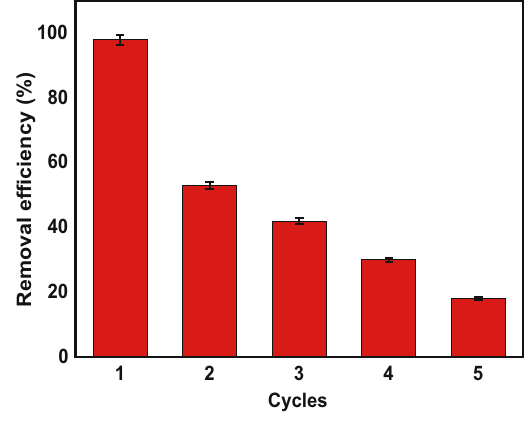
Figure 7: XPS high - resolution Cr 2p spectra of PDA/NC nanocom - posite after the removal of Cr ( VI ) ions.